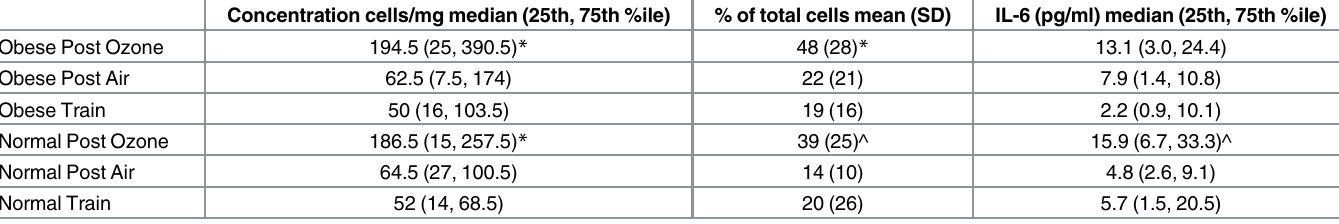
Table 6. Sputum PMNs (concentration and %of recovered cells) and Sputum IL-6 concentration (pg/ml).